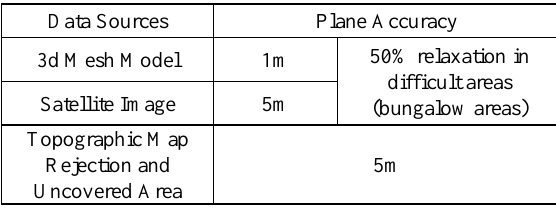
Table 3 . Quality requirements for plane accuracy.